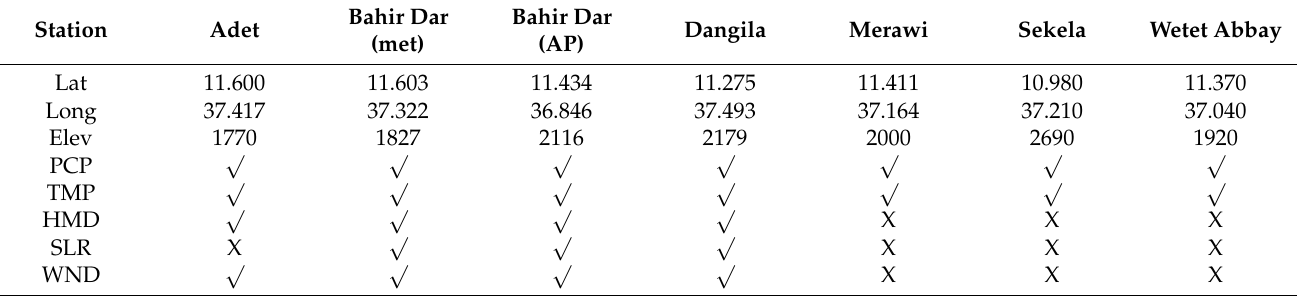
Table 1. The weather stations chosen and the daily data they